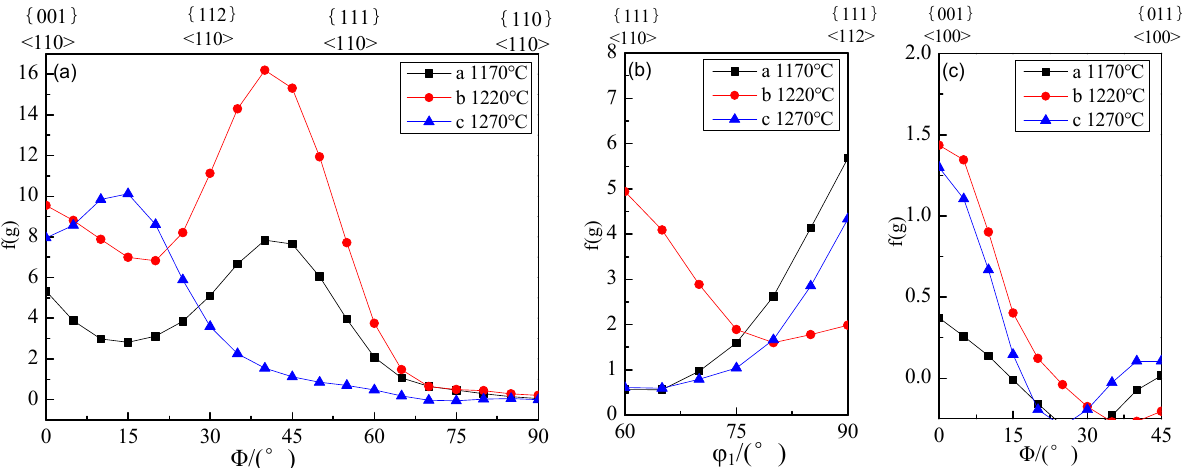
Figure 6. Orientation distribution intensities along ( a ) α -fiber, ( b ) γ -fiber, and ( c ) η -fiber after first cold rolling with different slab heating temperatures.